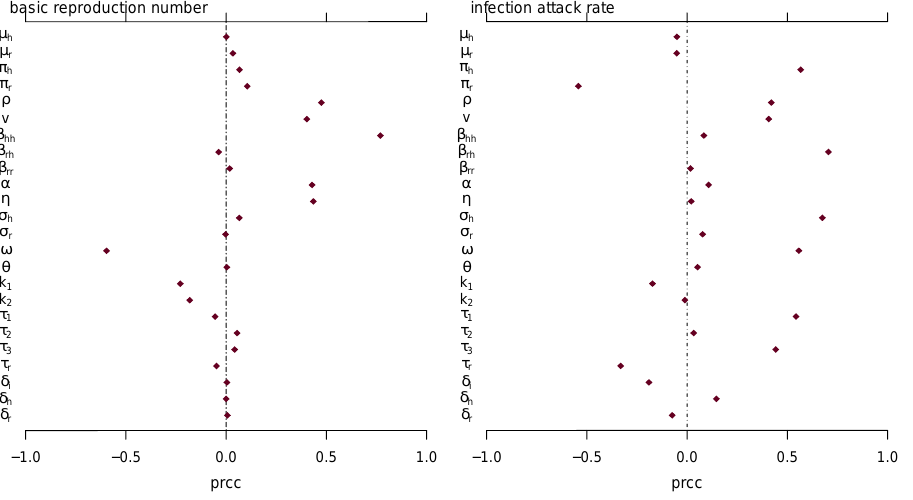
Figure 5. The infectious attack rate in connection to model parameters and the partial rank correlation coefficient of R 0 . The bars show the 95% confidence interval, while the dots show the calculated correlation. Table 2 summarises the values of the parameters